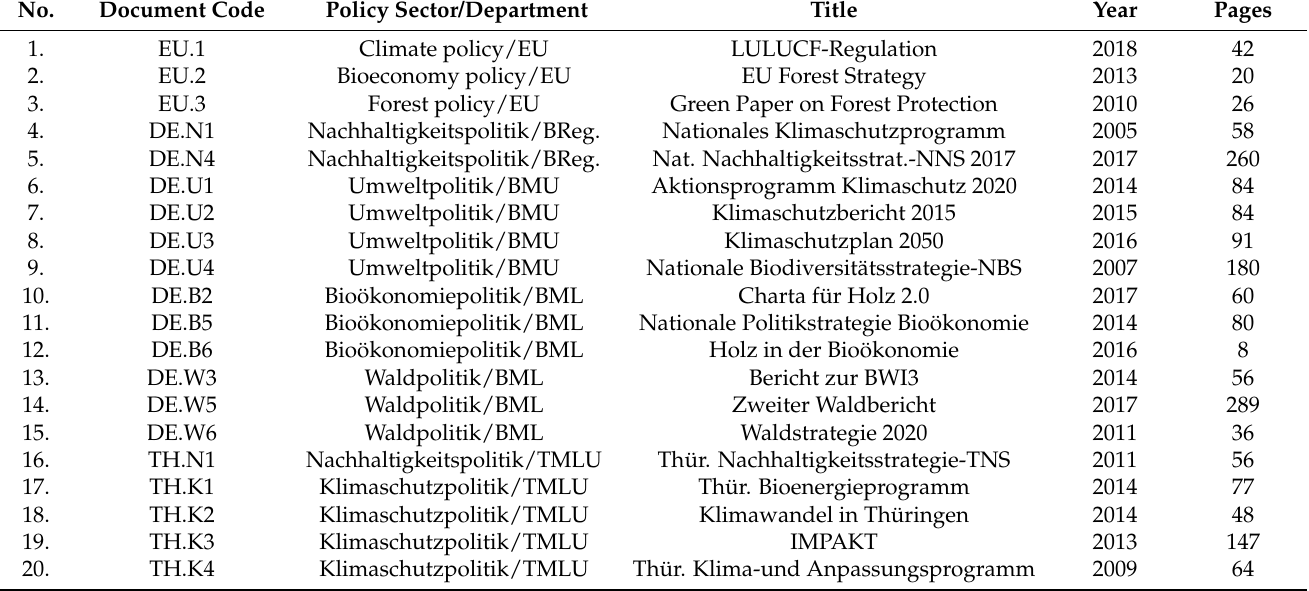
Table 1. Selected policy